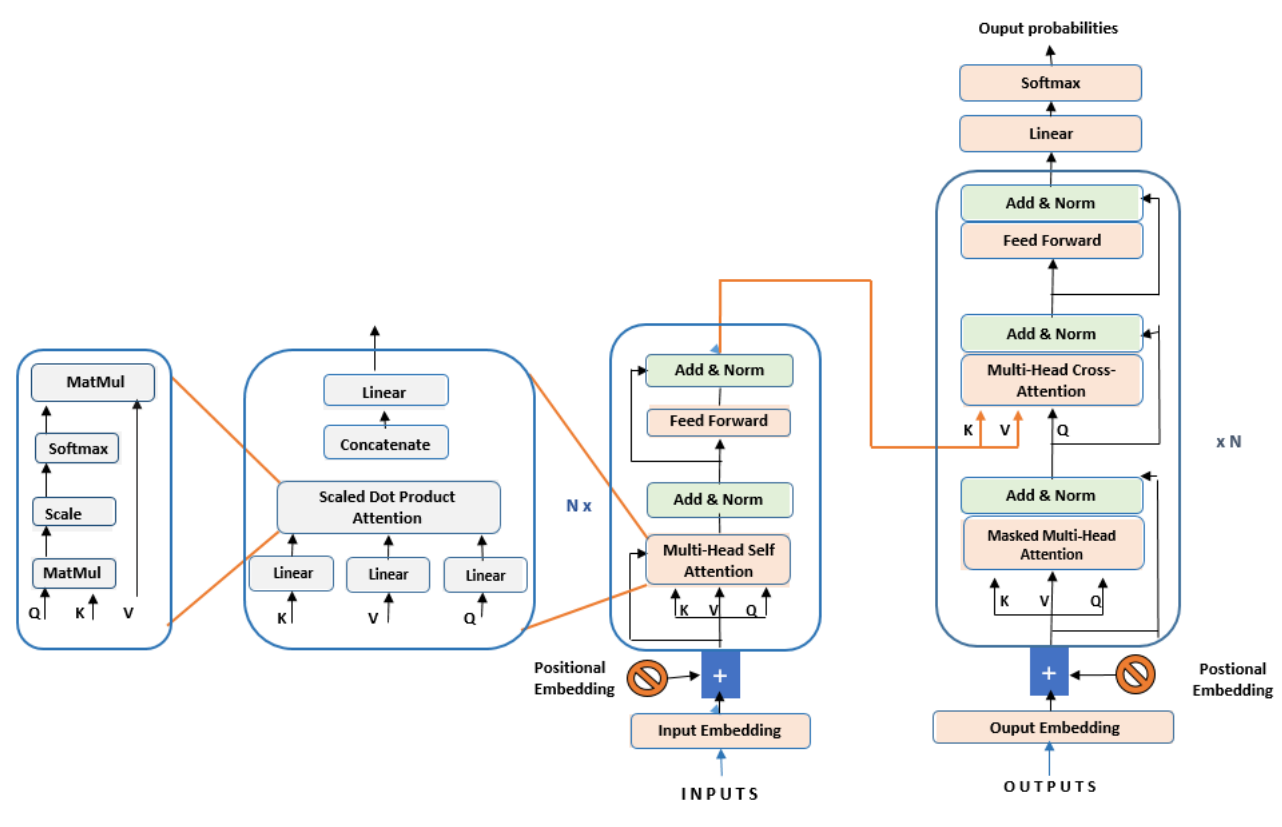
Figure 7. A well established standard transformer architecture